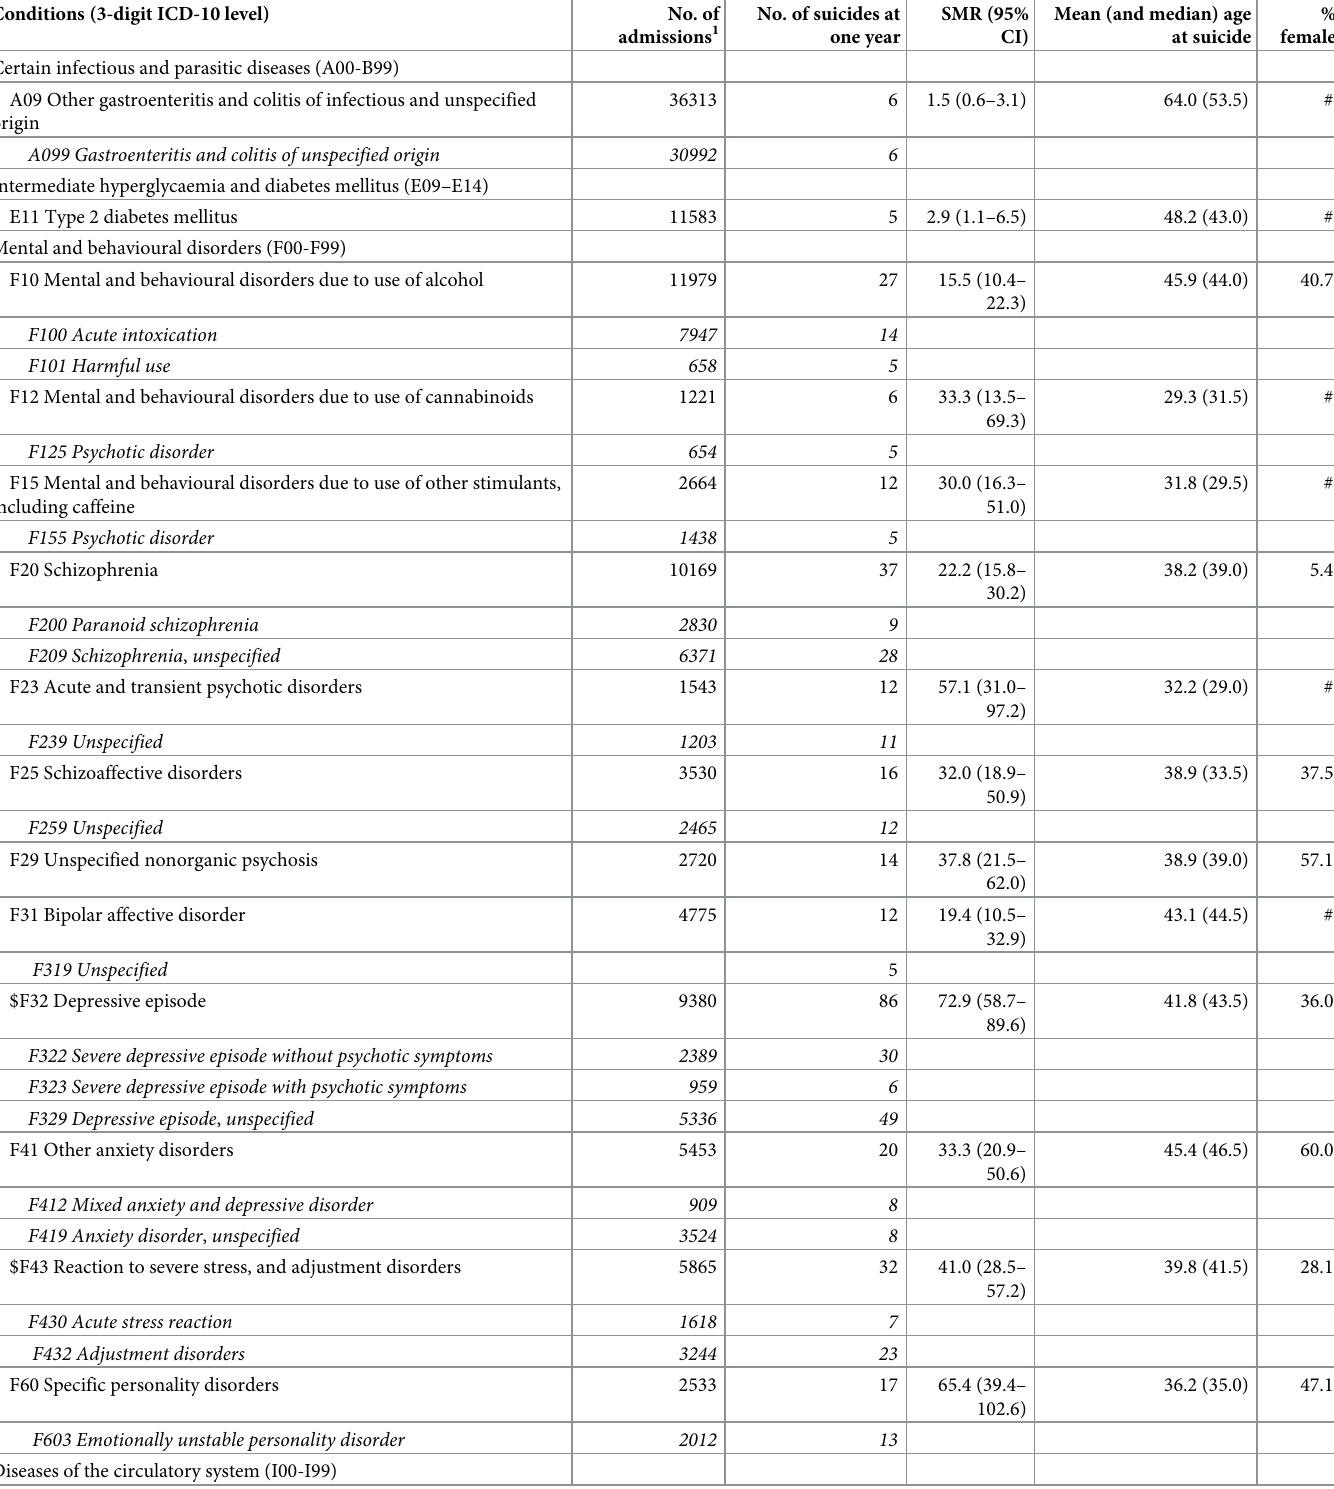
Table 2. Number of hospital admissions, suicides, SMRs and patient demographics for death by suicide within one year of hospital discharge (conditions with > = 5 suicides) Victoria, 2011 to